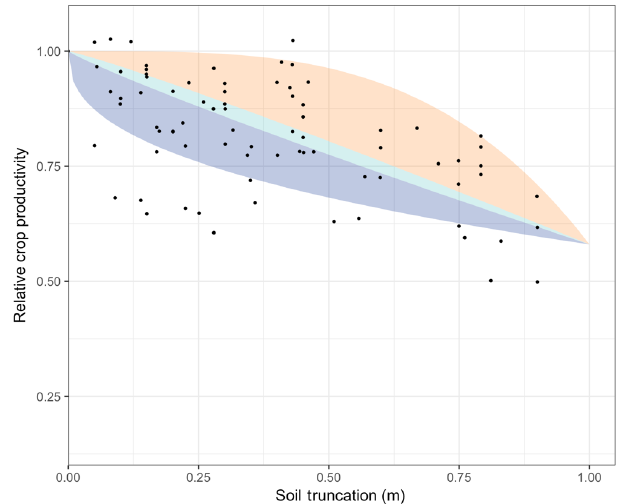
Figure 1. Relative crop productivity evolution as a function of soil truncation based on paired-plot experiments. Observations are taken from the data meta-analysis presented by Bakker et al. (2004). Val- ues larger than 1 indicate a gain in crop productivity and values smaller than 1 indicate a loss of crop productivity. The three shaded areas represent the space of the relationships investigated in our study. Dark blue, cyan and orange shades denote the concave re- lationship ( B< 0 . 9), linear relationship (0 . 9 <B< 1 . 1) and convex relationship ( B> 1 . 1)